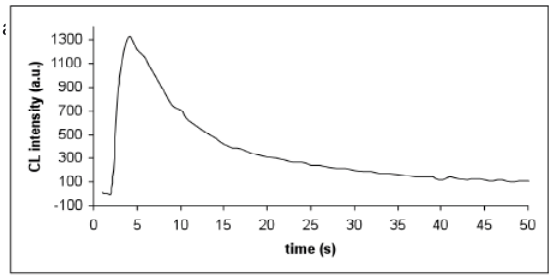
Figure 1. CL time profile. Reagent 1: 2% (w/v) CTMAB, 30% (v/v) DMF, pH 12; Reagent 2: 5% (w/v) H